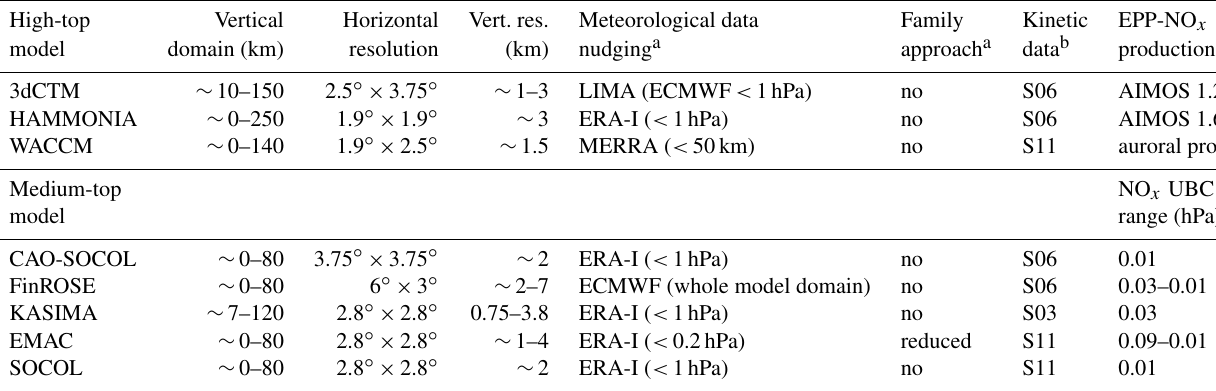
Table 1. Summarized description of the atmospheric models involved in this study. High-top Vertical Horizontal Vert.